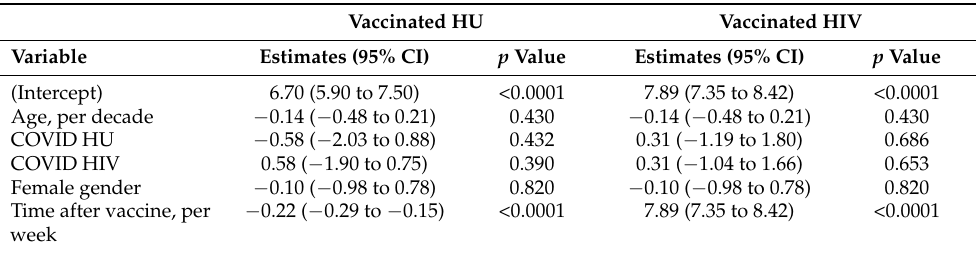
Table 5. Multivariate linear regression analysis of the serum spike-specific IgA levels of SARS-CoV-2 vaccinated subjects compared to COVID-19 convalescent subjects.